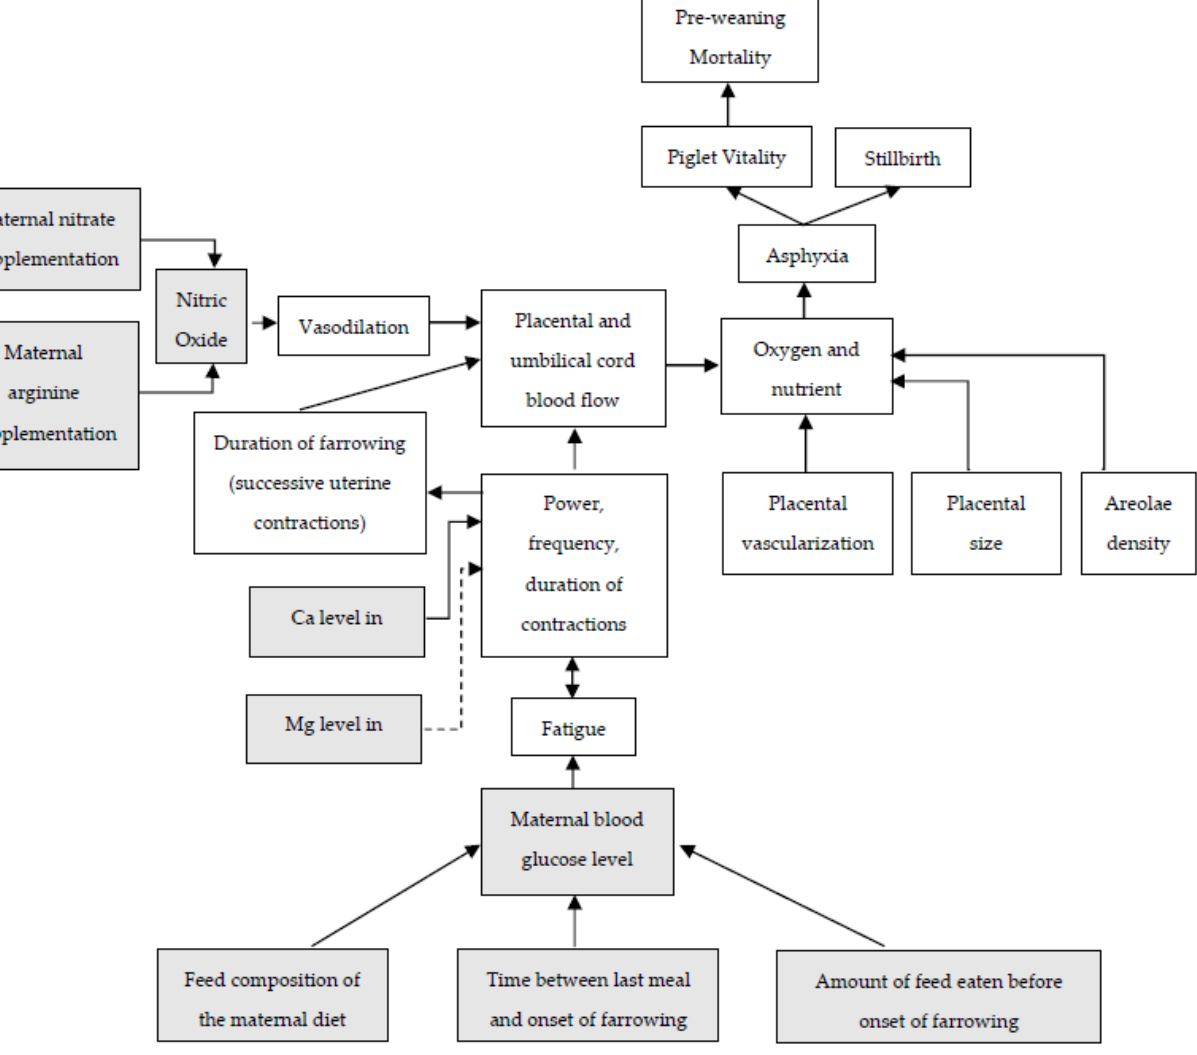
Figure 3. Relationships between farrowing and placental characteristics on piglet vitality, incidence of stillbirth and pre-weaning mortality, and potential roles of maternal nutrients on these relationships. Dotted lines indicate a negative effect. Grey boxes will be discussed in current paragraph.